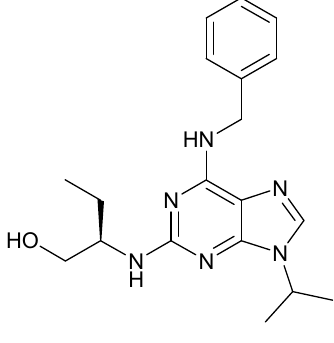
Figure 13. R-roscovitine. Figure 13.